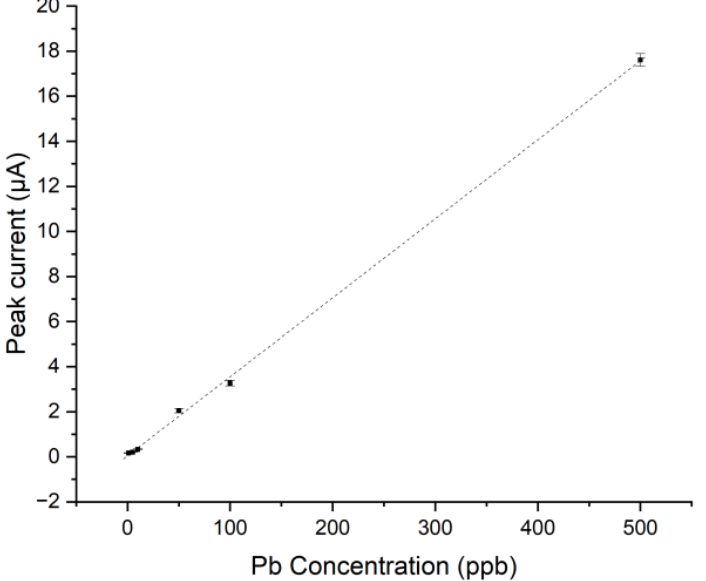
Figure 10. Calibration curve of Pb(II) from 1 µg/L to 500 µg/L detected by commercial sensor with modified Nafion.